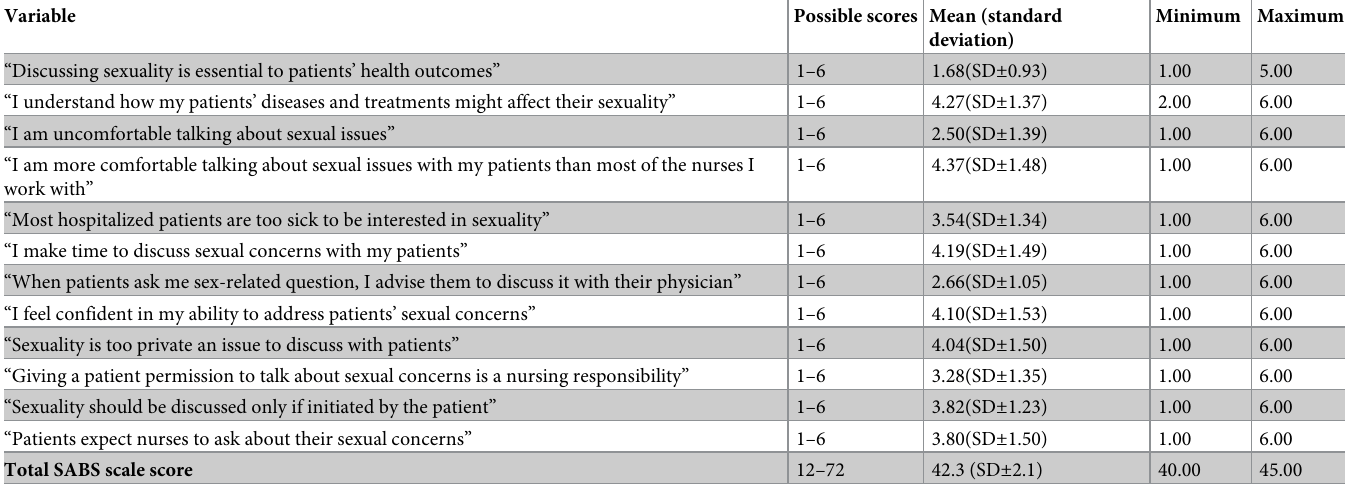
Table 3. Attitudes and beliefs of nursing students regarding sexual healthcare (n =